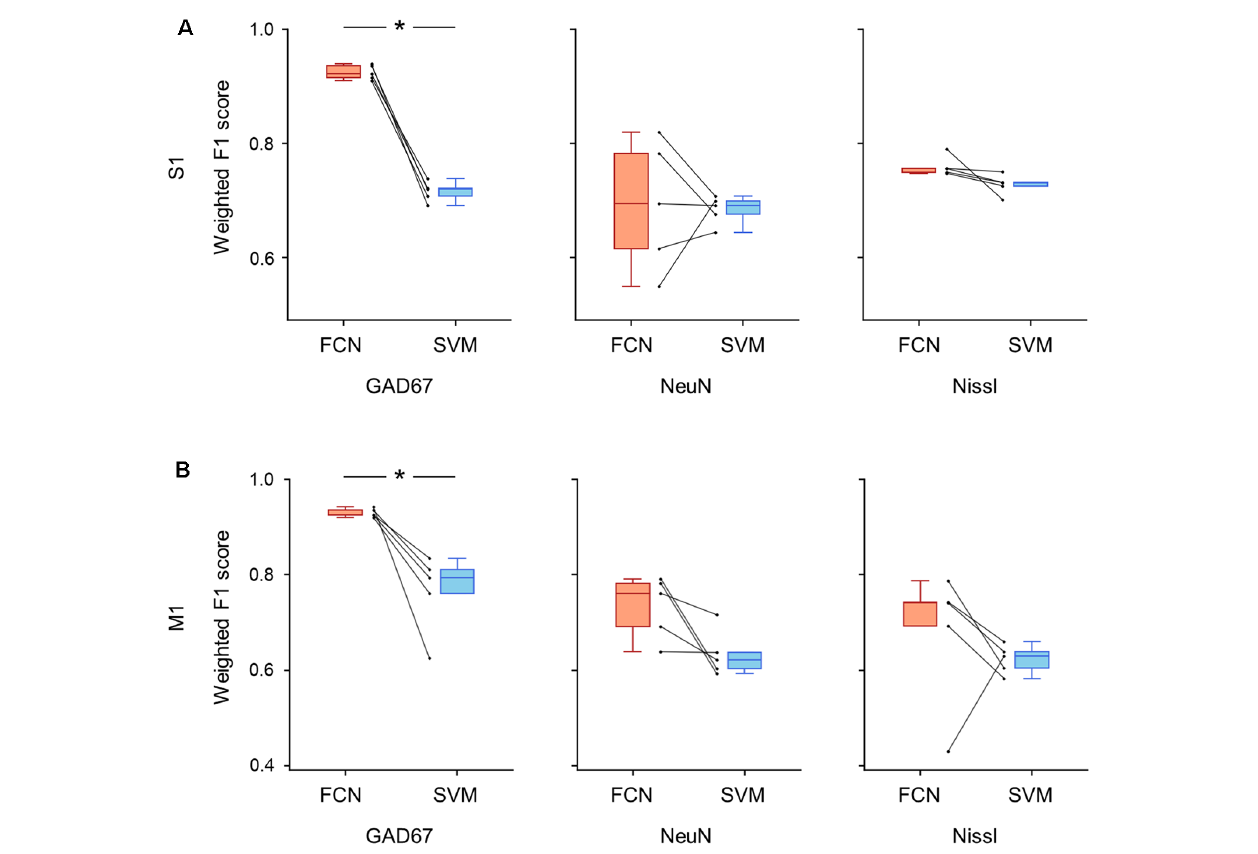
FIGURE 8 | Classification performance of cell images using single fluorescent signals. (A) Weighted F1 score of the FCN model (red) and the PCA-SVM classifier (blue) trained on cell images from S1. Left: classification performance using an anti-GAD67 signal. Each point (gray) signifies the score for the cross-validation (5-fold). P = 5.6 × 10 –5 , t (4) = 18.0, n = 5-fold cross-validations, paired t -test. * P < 0.05. Middle, the same as on the left, but for an anti-NeuN signal. P = 0.87, t (4) = 0.18, n = 5-fold cross-validations, paired t -test. Right: the same as on the left, but for a Nissl signal. P = 0.09, t (4) = 2.18, n = 5-fold cross-validations, paired t -test. (B) The same as (A) , but for M1. Left, P = 0.01, t (4) = 4.1, n = 5-fold cross-validations, paired t -test. * P < 0.05. Middle, P = 0.06, t (4) = 2.6, n = 5-fold cross-validations, paired t -test. Right, P = 0.22, t (4) = 1.45, n = 5-fold cross-validations, paired t -test. Abbreviations: S1, primary somatosensory cortex; M1, primary motor cortex; FCN, fully convolutional network; SVM, support vector machine; PCA, principal component